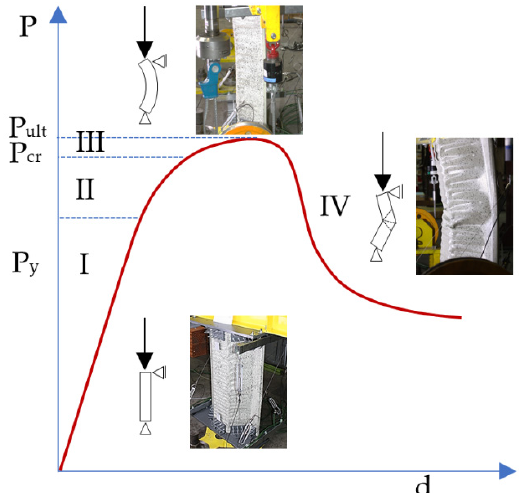
Figure 3. Shells’ behaviour. Buckling in the elastoplastic range. P Y —yield point, P cr —critical point, P ult —ultimate point, d—displacement. I—pre-buckling, II—pre-buckling elastoplastic range, III—post-buckling elastoplastic range, IV—failure.